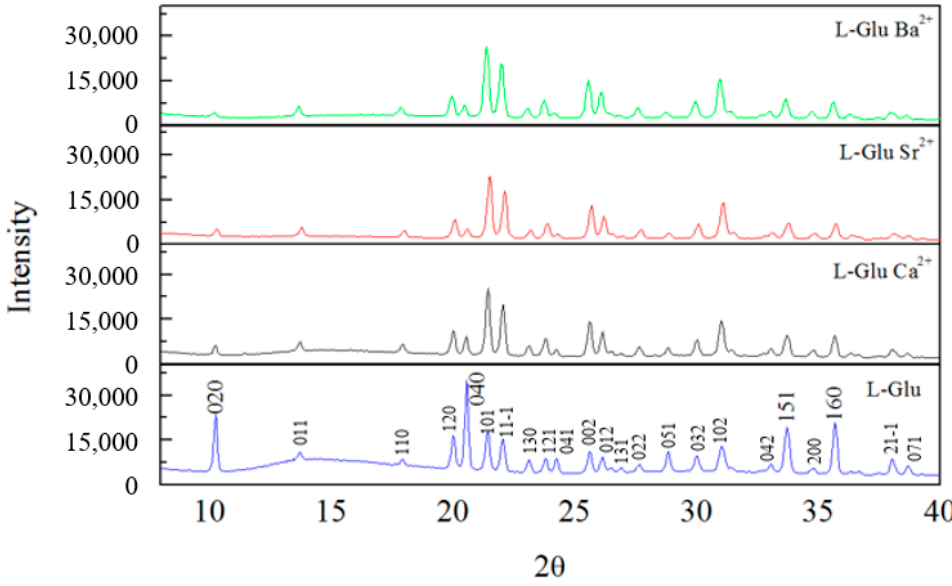
Figure 4. XRD spectra of L-glu and L-glu crystallized with barium, strontium and calcium ions.